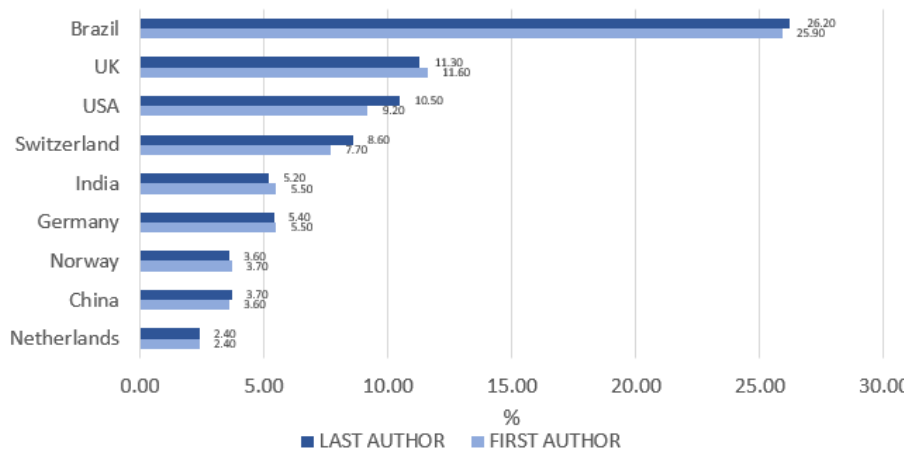
Figure 3. Origin of affiliation of the published articles